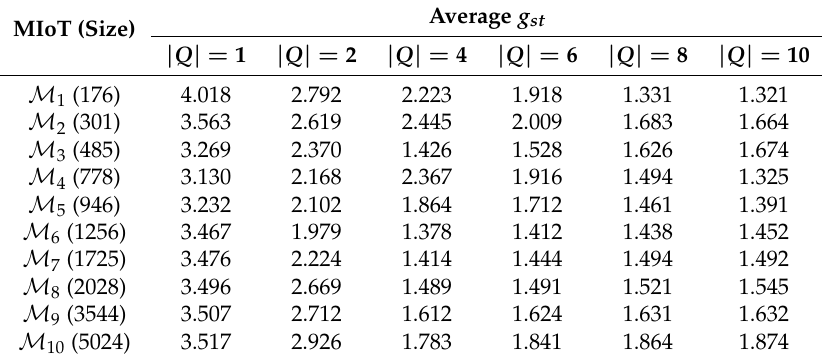
Table 12. Average values of g st against the size of MIoTs and queries used to generate the virtual IoTs (supervised approach).